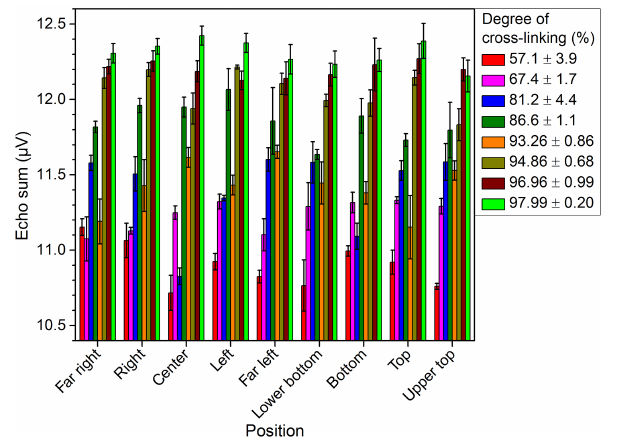
Figure 6. Echo sum vs. degree of cross-linking of PE-Xa using the CPMG pulse sequence.